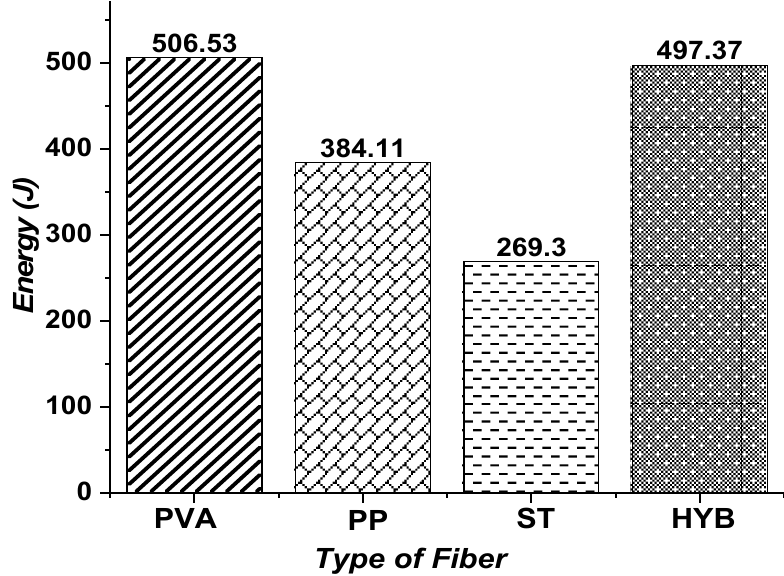
Figure 8. Energy absorption capacity of ECC beams with mono and hybrid fibers.